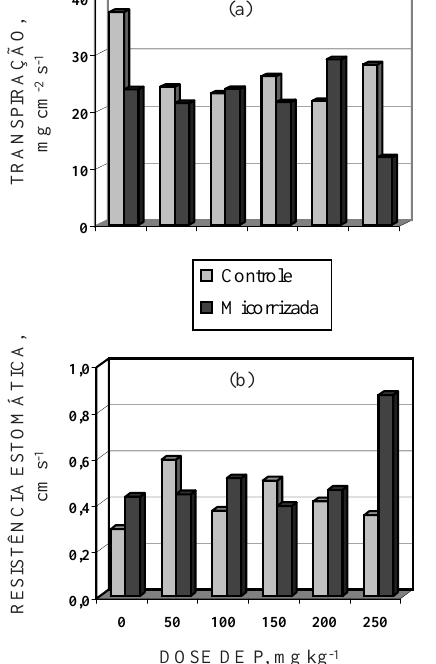
Figura 2. Transpiração (a) e resistência estomática (b) de plantas da tangerineira “Cleópata” inoculadas ou não com fungo micorrízico arbuscular e cultivadas com diferentes doses de